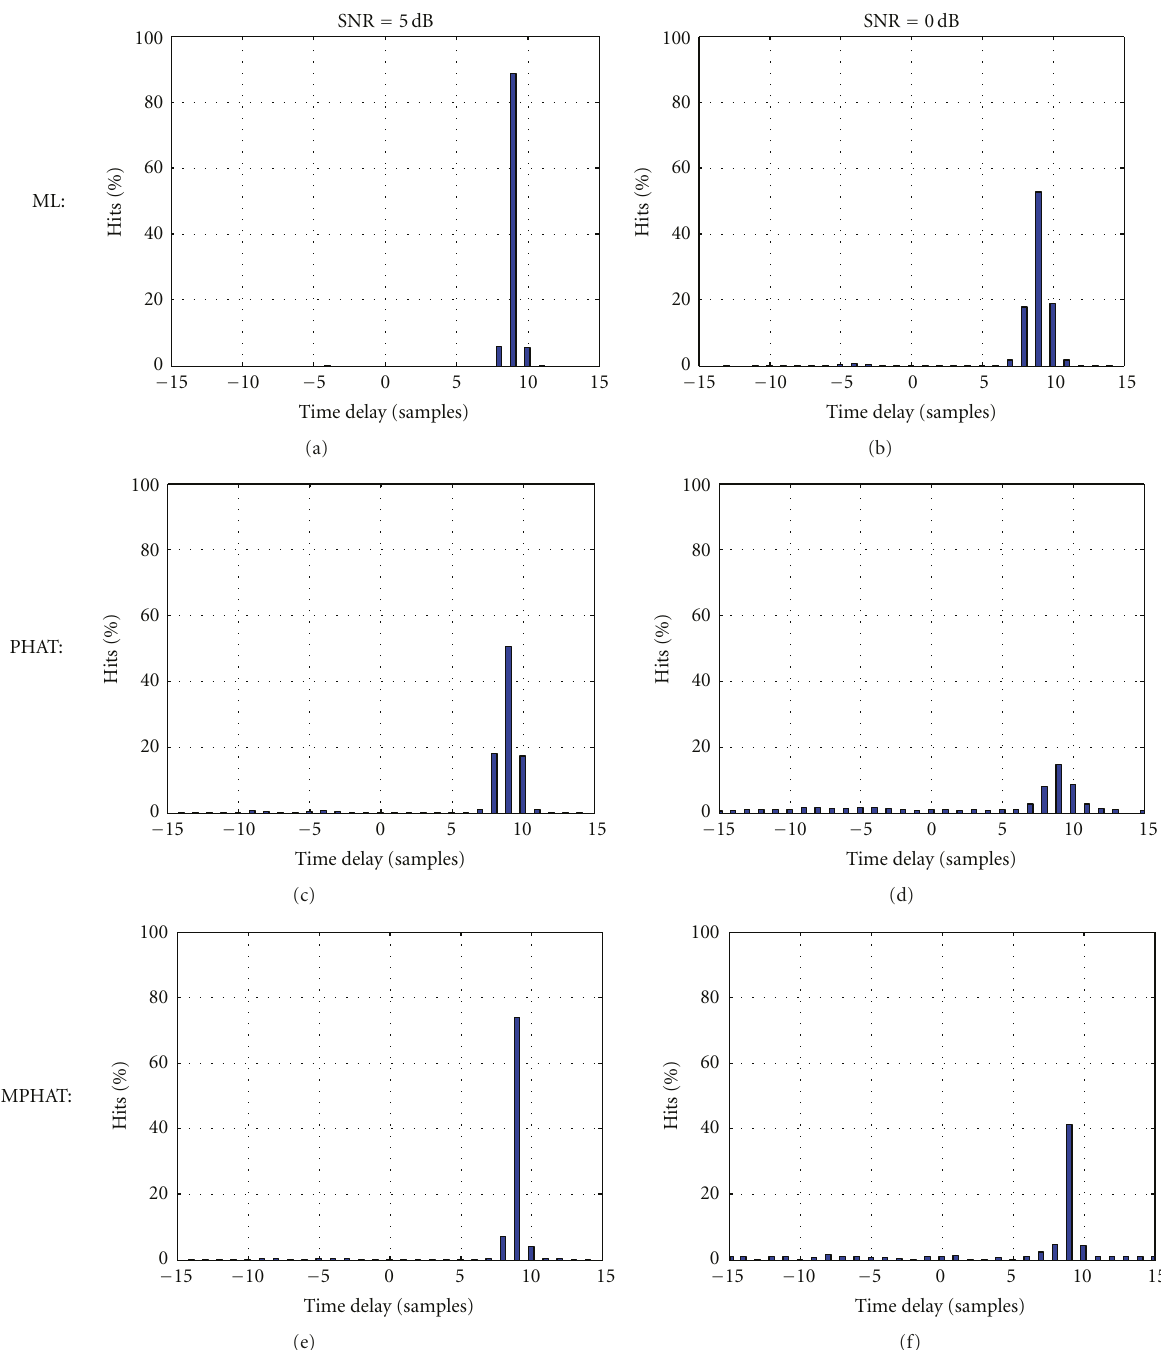
Figure 4: TDE performance in noisy situations (exact value of TDOA is 9